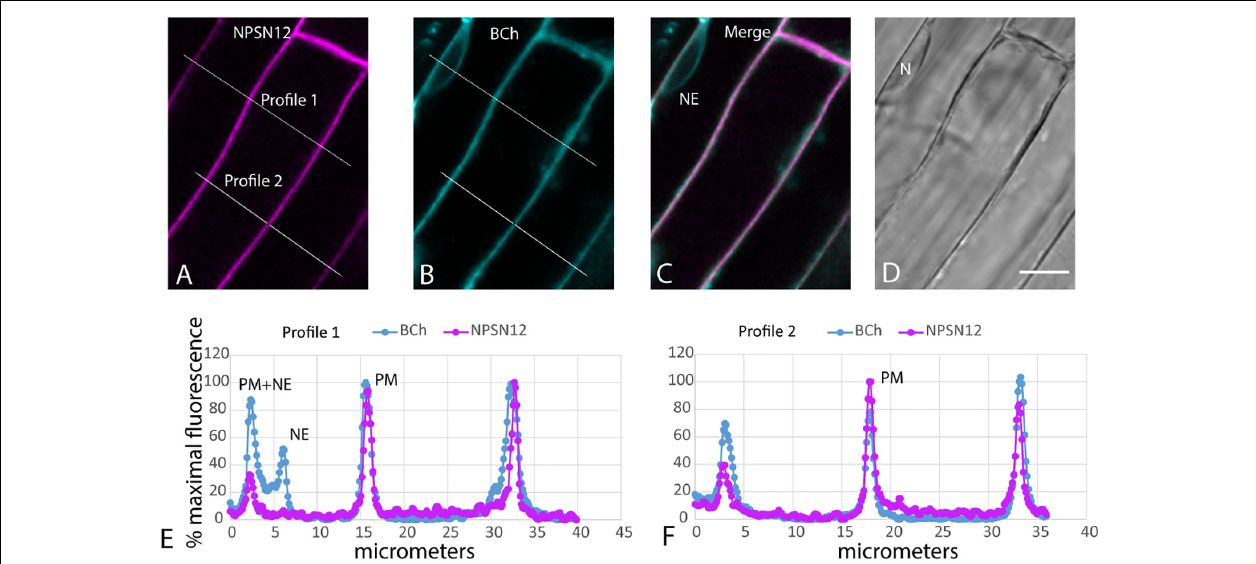
FIGURE 6 | Label with BCh colocalizes with the PM and NE in elongating root cells. Five-day-old seedlings expressing NPSN12-mCherry were treated with BCh for 15 min. (A) PM marker NPSN12-mCherry fluorescence (magenta). (B) BCh signal (cyan). Line profiles in (A and B) are the same, and intensities are plotted in (E and F) . (C) Merged image, NE, nuclear envelope. (D) Bright-field image, N, nucleus. Scale bar = 10 µ m. (E) Percentage of maximal fluorescence along line profile 1 in (A) NPSN12-mCherry (magenta) and (B) BCh (cyan). (F) Percentage of maximal fluorescence along line profile 2 in (A) NPSN12-mCherry (magenta) and (B) BCh (cyan). Colocalization at the PM is shown for two different cells at the center peak. NE peaks from (B) are shown as NE in (E) .